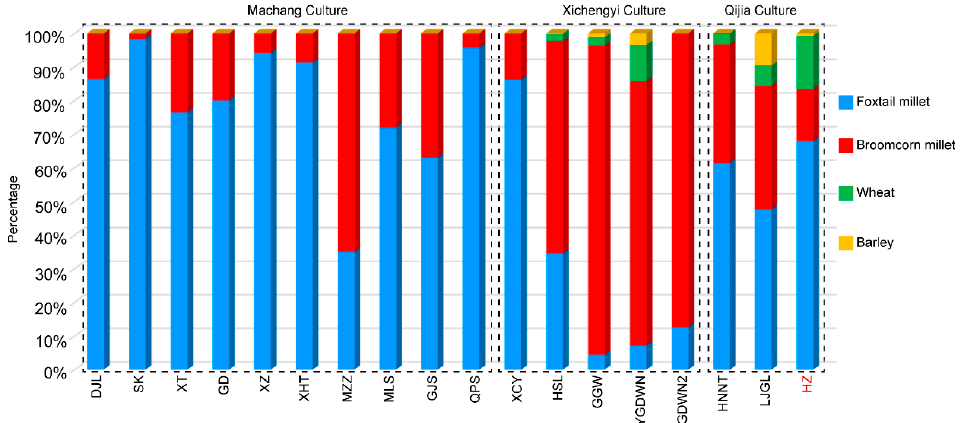
Figure 3. Percentage of charred crop seeds unearthed from Machang culture, Xichengyi culture and Qijia culture sites in the Hexi Corridor. DJL, SK, XT, GD, XZ, XHT, MZZ, MLS, GJS, QPS, XCY, HSL, GGW, YGDWN, YGDWN2, HNNT, LJGL, and HZ represents Duojialiang, Shuikou, Xitai, Guandi, Xinzhai, Xihetan, Mozuizi, Maolinshan, Guojiashan, Qipanshan, Xichengyi, Huoshiliang, Gang- gangwa, Yigediwonan, Yigediwonan2, Huangniangniangtai, Lijiageleng, and Haizang.